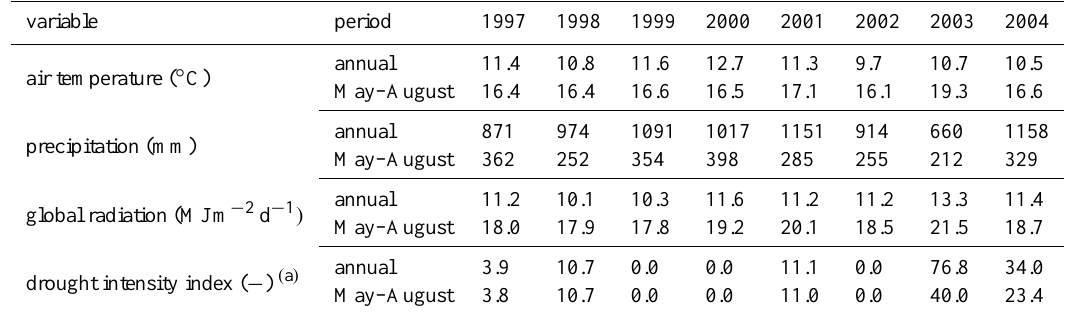
Table 1. Annual- and growing season air temperature (mean), precipitation (sum), global radiation (mean) and drought intensity (index) at the beech stand of Hesse during the study period.